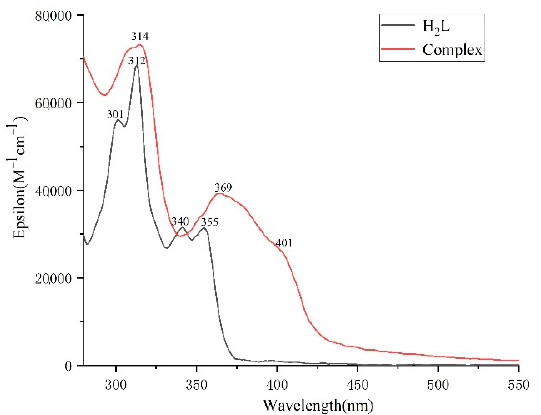
Figure 1. UV-Vis spectra of H 2 L and its Cu II